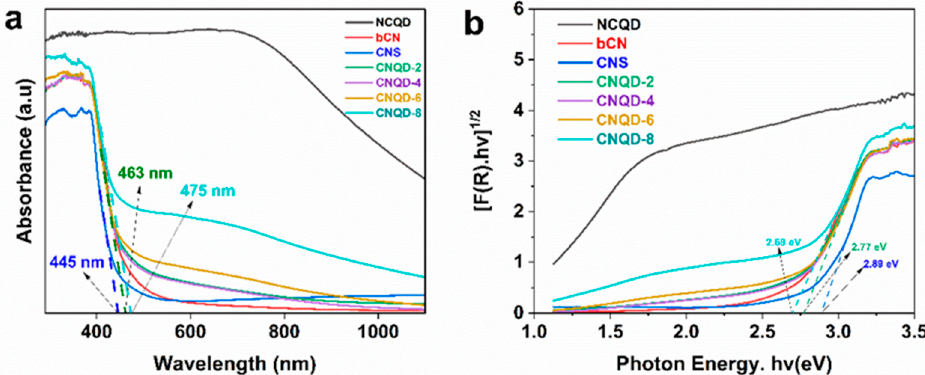
Figure 9. UV/Vis-DRS ( a ) and Tauc plots ( b ) of NCQD, bCN, CNS, and CNQD photocatalysts.